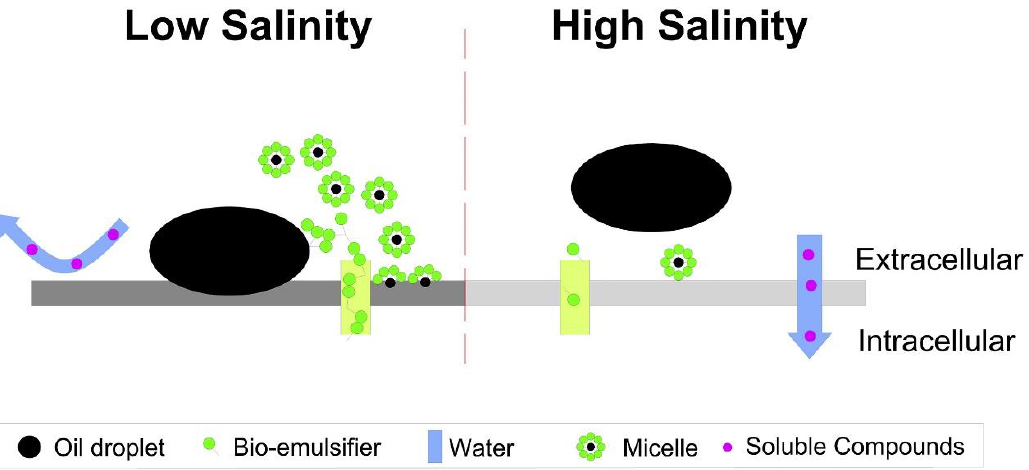
Figure 15. A schematic diagram describing the microbial eco-physiological mechanism when facing crude oil under low and high salinities. Adapted from Cao, et al. [185].